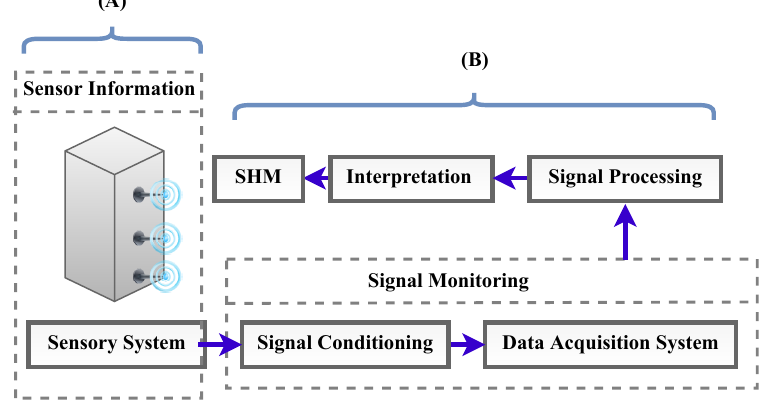
Figure 9. Components of a general SHM system—( A ) sensing and ( B ) data analysis. Several bridges in the world have been equipped with SHM systems using different currently being monitored using SHM